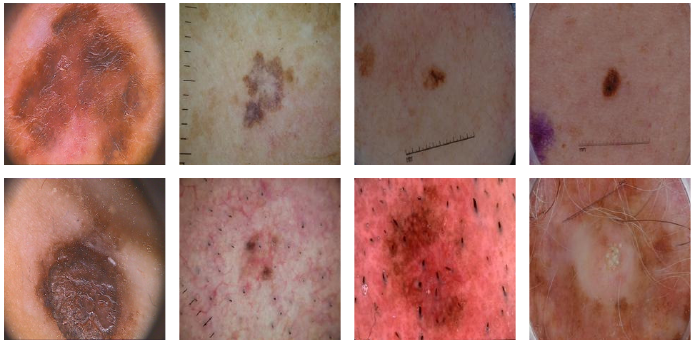
Figure 1. Two samples ( top and bottom ) of PH 2 and ISIS 2016, 2017, and 2018 ( left to right